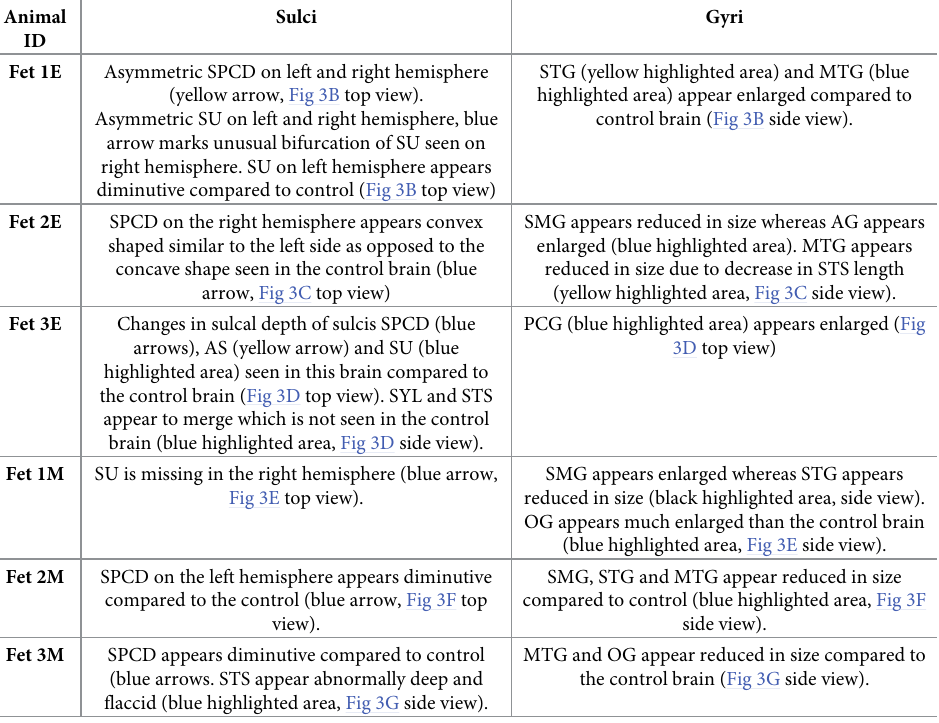
Fet 3M SPCD appears diminutive compared to control (blue arrows. STS appear abnormally deep and flaccid (blue highlighted area, Fig 3G side view). AG, Angular gyrus; AS, Arcuate sulcus; MTG, Middle Temporal Gyrus; OG, Occipital gyrus; PCG, Postcentral gyrus; SMG, Supramarginal gyrus; SPCD, Superior Precentral dimple; STG, Superior Temporal gyrus; STS, Superior Temporal Sulcus; SU, Superior Postcentral dimple; SYL, Sylvian